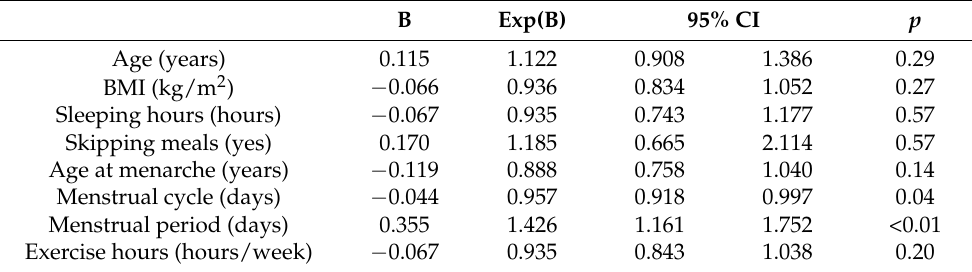
Table 5. Factors related to the severity of dysmenorrhea in